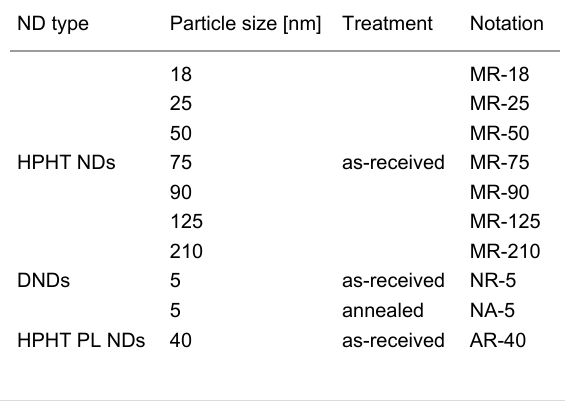
Table 1: Characteristics and notation of diamond nanoparticle (ND) samples. ND